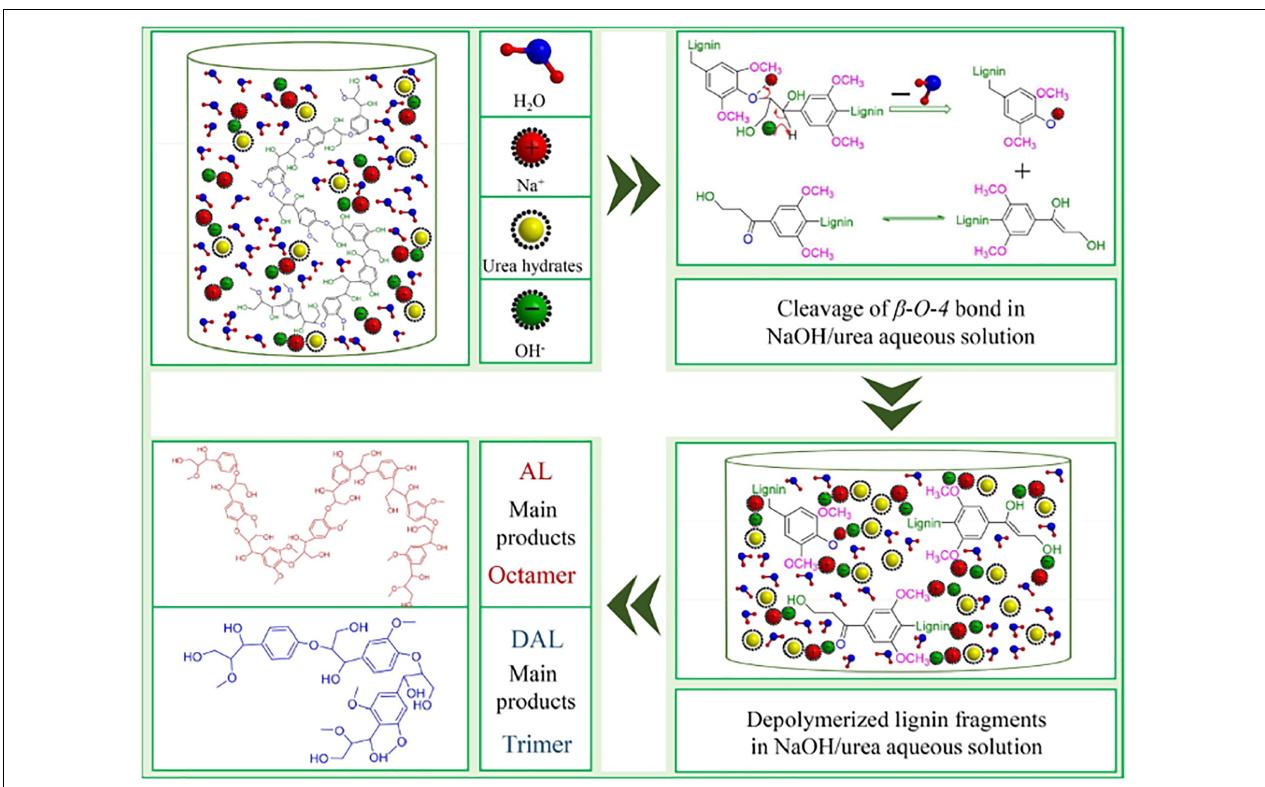
FIGURE 3 | Schematic diagram of NaOH/urea aqueous solution to depolymerize the alkali lignin to prepare low molecular weight lignin derivatives (Li et al.,